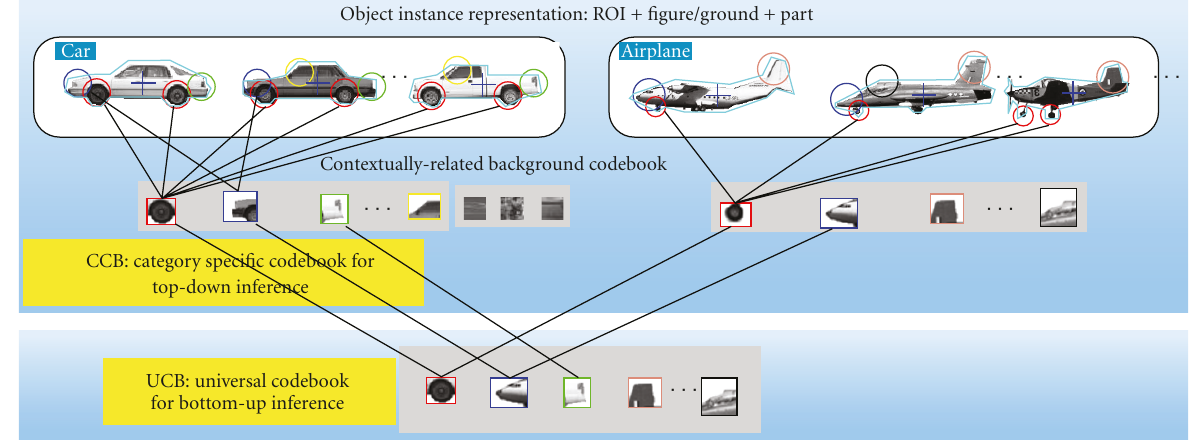
Figure 10: Category representation by two-layered codebook (universal codebook + category-specific codebook) with object instance representation.